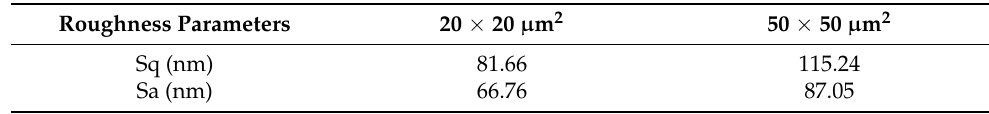
Table 7. The roughness parameters of starch-based